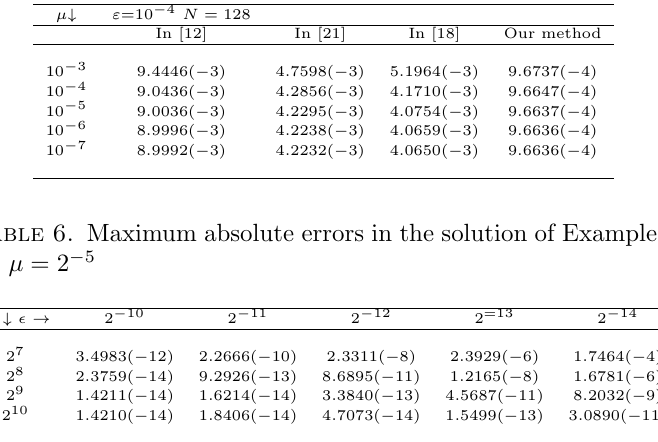
Table 5. Maximum absolute errors in the solution of Example 2